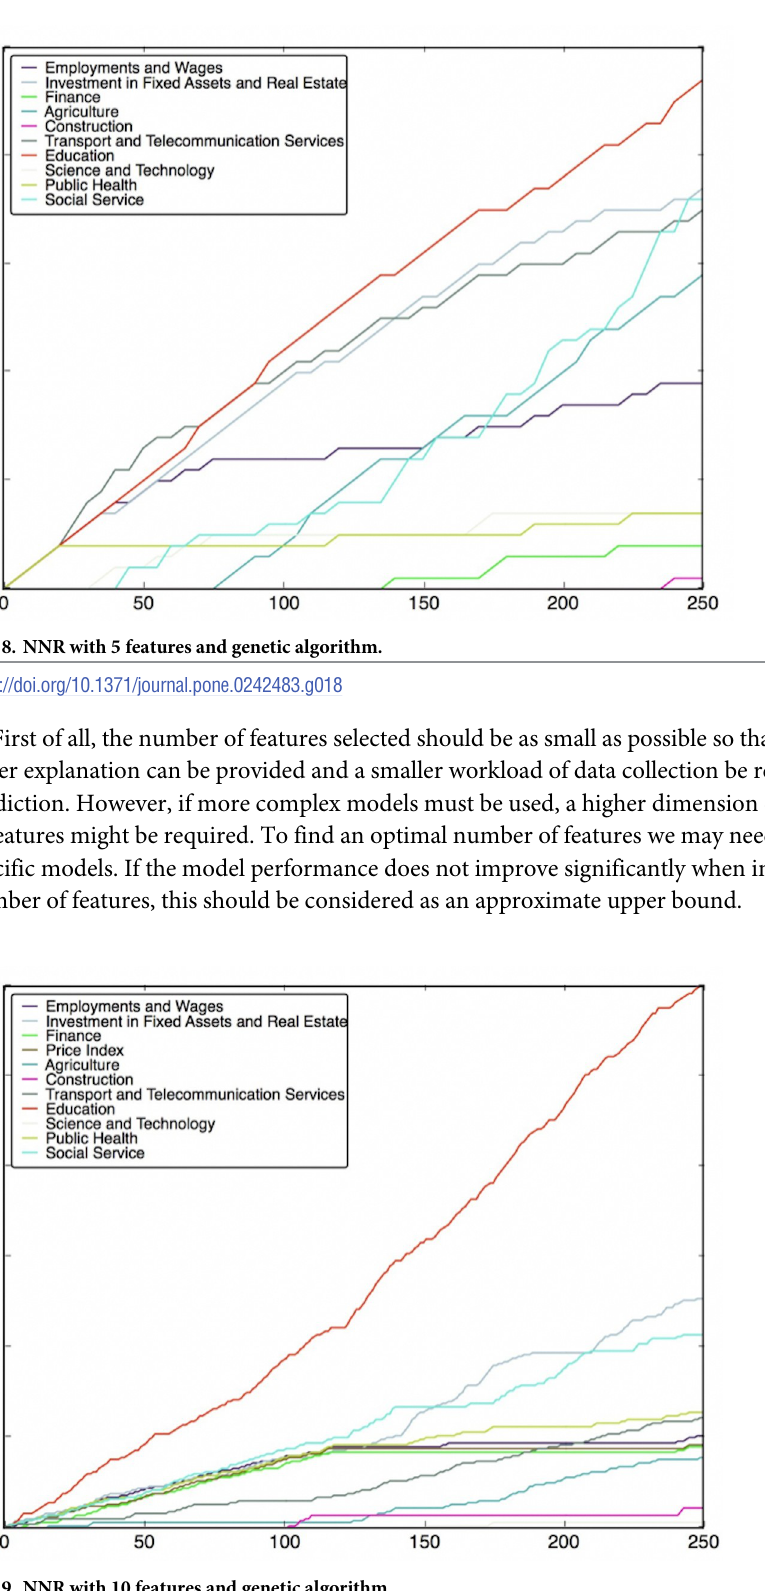
Fig 19. NNR with 10 features and genetic